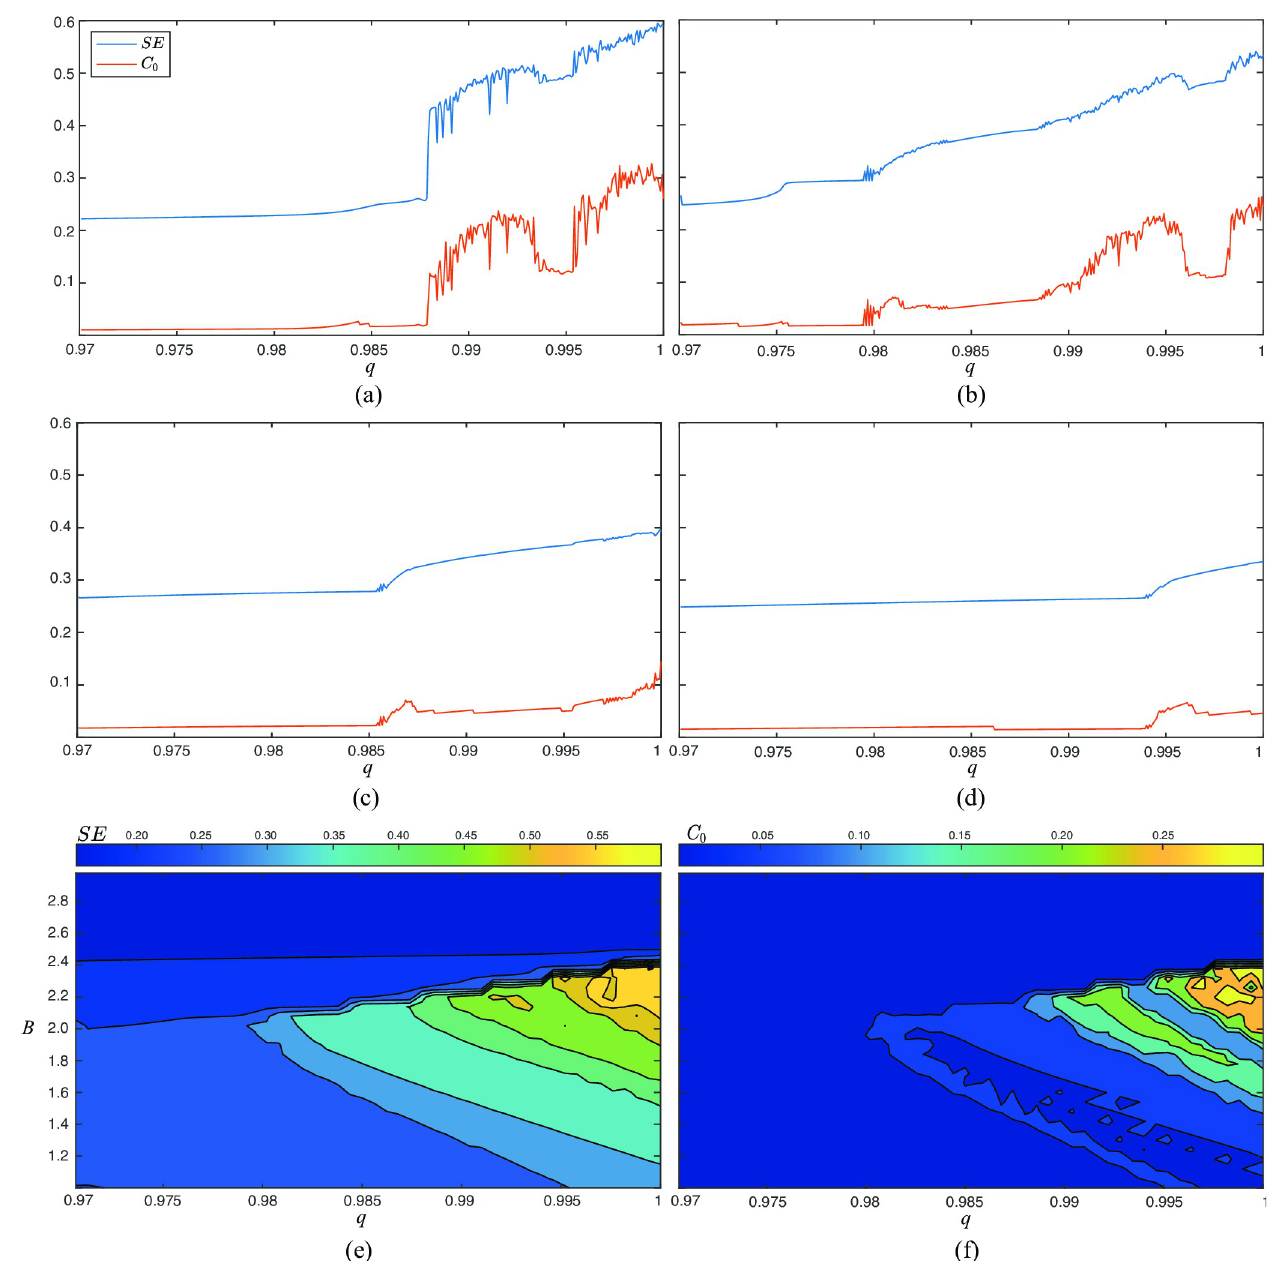
Fig 2. Variation of SE and C 0 as a function of B and q for several scenarios. In all cases, SE and C 0 were computed from the variable x ( n ) and the parameters ρ = 11 and ω = 1.5 were used. In the first four panels the parameter B took values of (a) 2.2, (b) 2.0, (c) 1.5, and (d) 1.0. The two last panels show contour plots for (e) SE, and (f) C 0 , when values of B and q range from 1 to 3, and from 0.97 to 1,